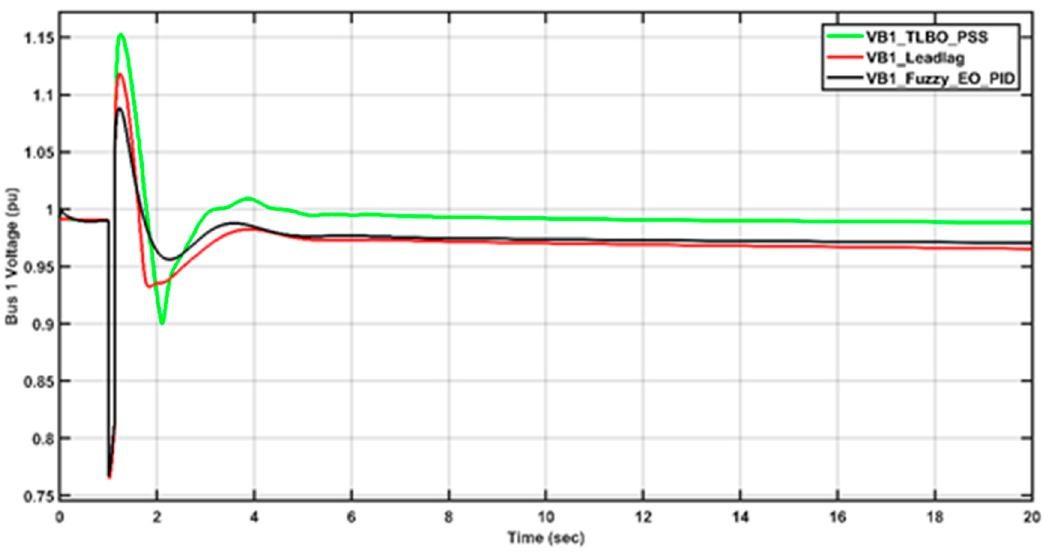
Figure 17. Tie power results for Kundur system.